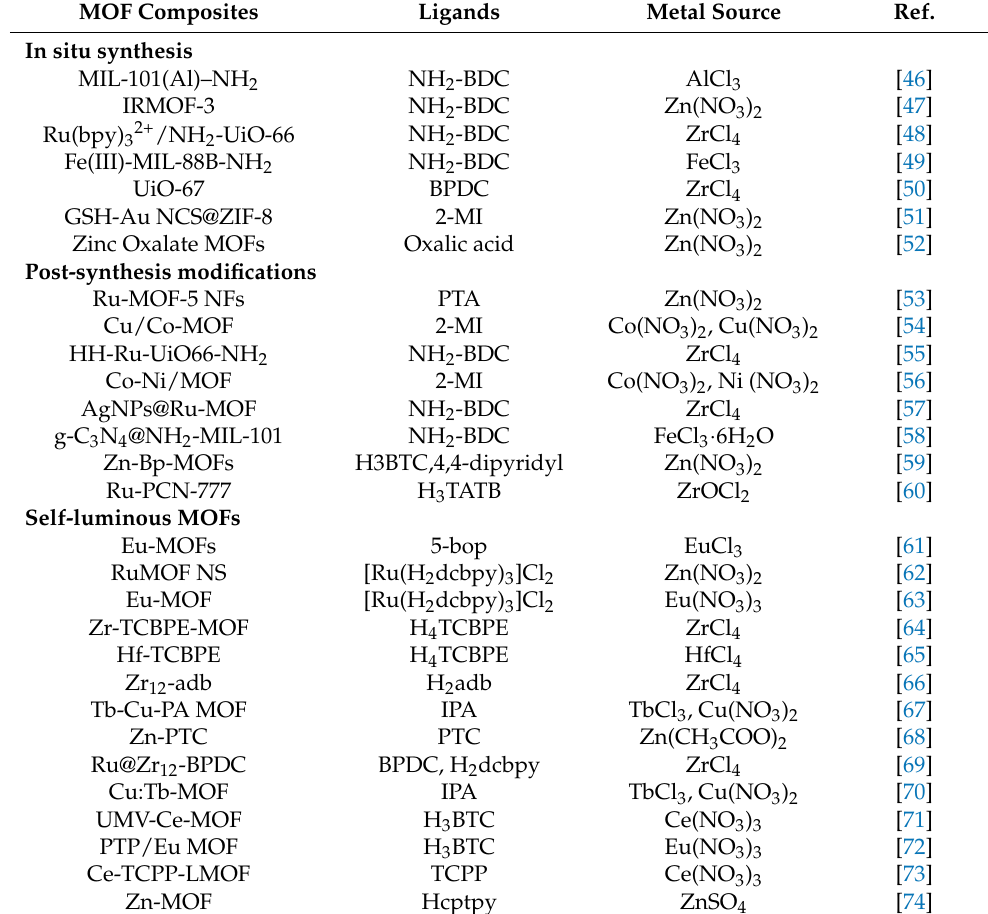
Table 2. Summary of different synthetic strategies for MOF composites with ECL properties. MOF Composites Ligands Metal Source